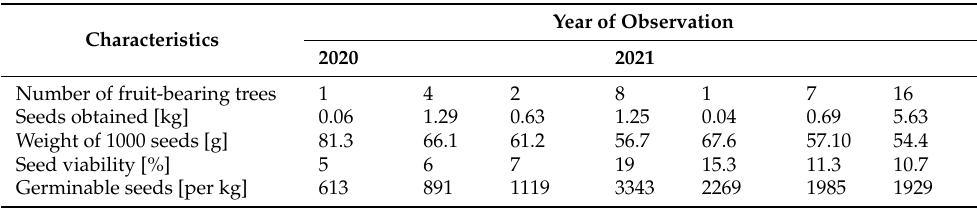
Table 1. Fruiting dynamics and seed quality analysis performed by the Seed Quality Assessment Station in